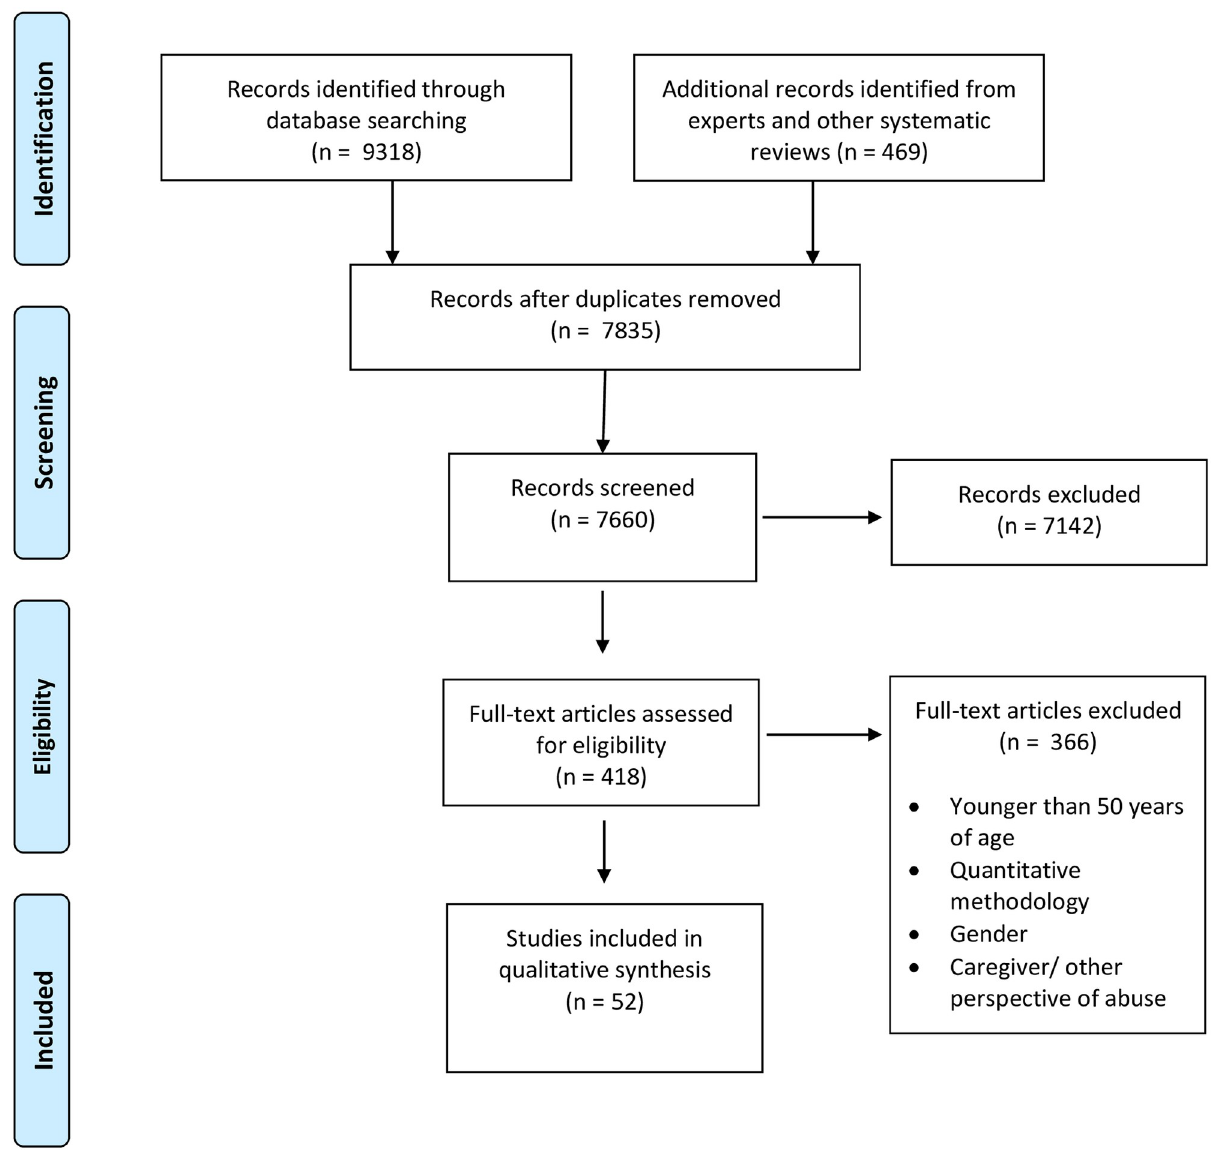
Fig 1. Identification of included studies. From : Moher D, Liberati A, Tetzlaff J, Altman DG, The PRISMA Group (2009). Preferred Reporting Items for Systematic Reviews and Meta-Analyses: The PRISMA Statement. PLoS Med 6(6): e1000097. doi:10.1371/journal.pmed1000097. For more information, visit